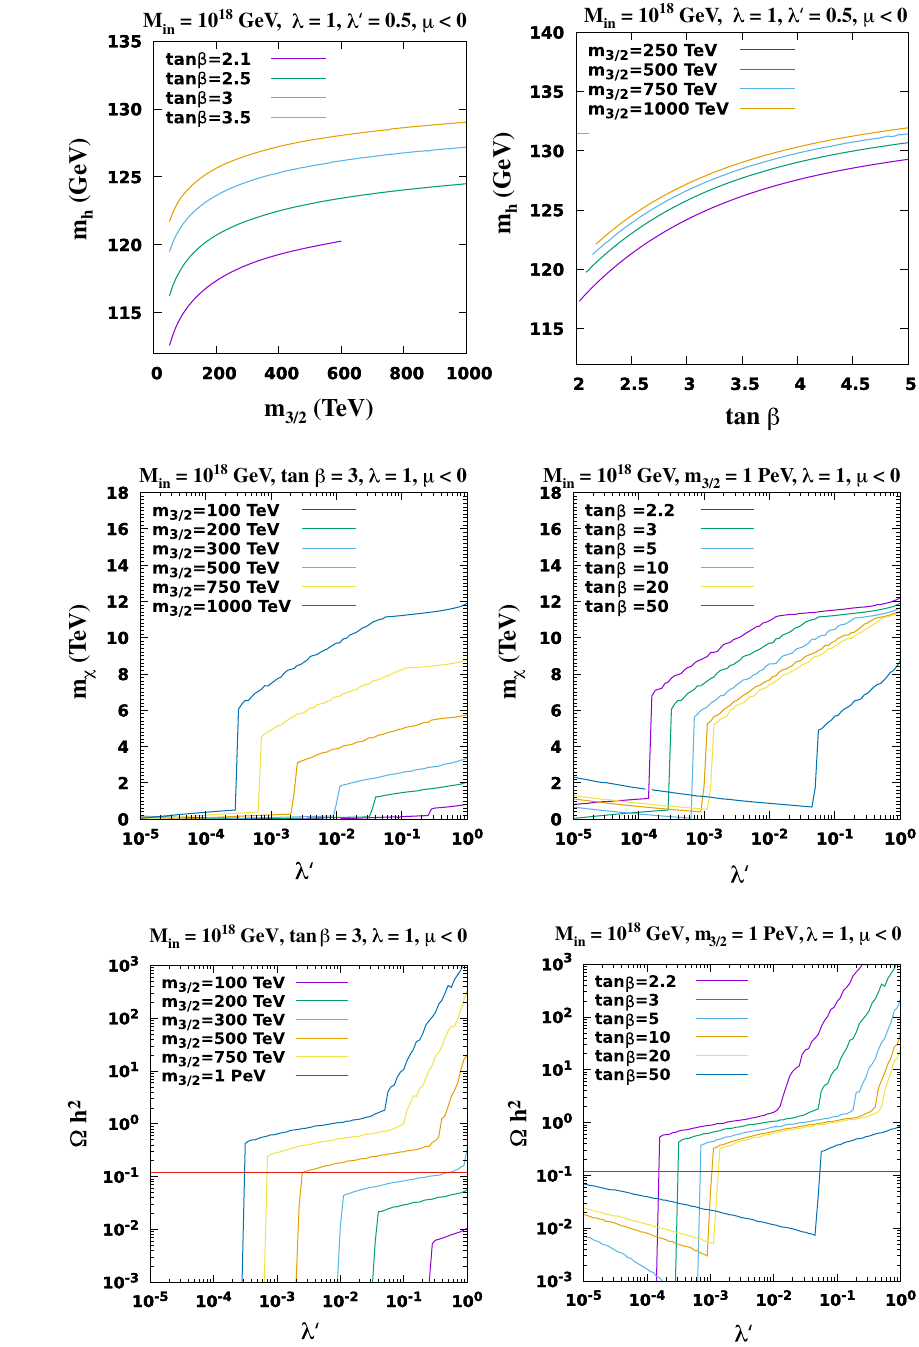
Fig. 3 The Higgs mass m h as a function of a m 3 / 2 for several values of tan β and b as a function of tan β for several values m 3 / 2 with λ = 1 . 0, λ (cid:7) = 0 . 5, M = 10 18 GeV, and in